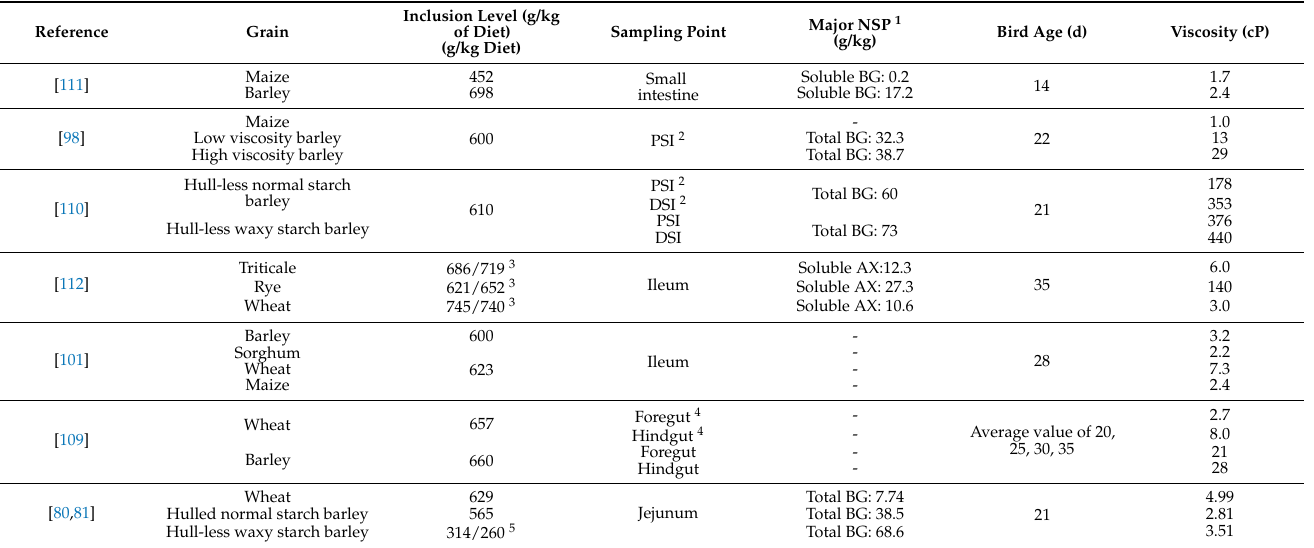
Table 5. Comparison of different cereal types for intestinal digesta viscosity of